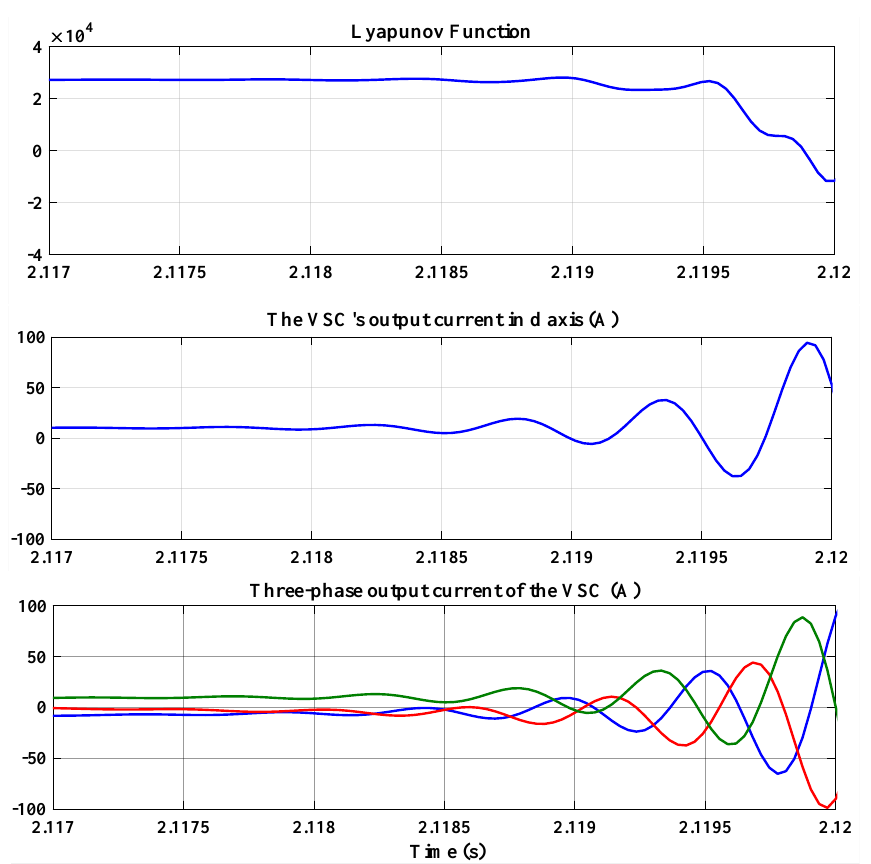
Figure 11. The Lyapunov function and the VSC’s output current in d-axis and in the three-phases for a step change in K P value from 80 to 160 at t = 2